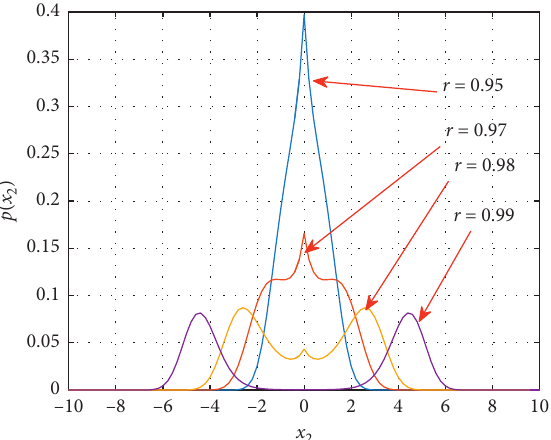
Figure 8: Section graphs of joint PDFs on the surface x